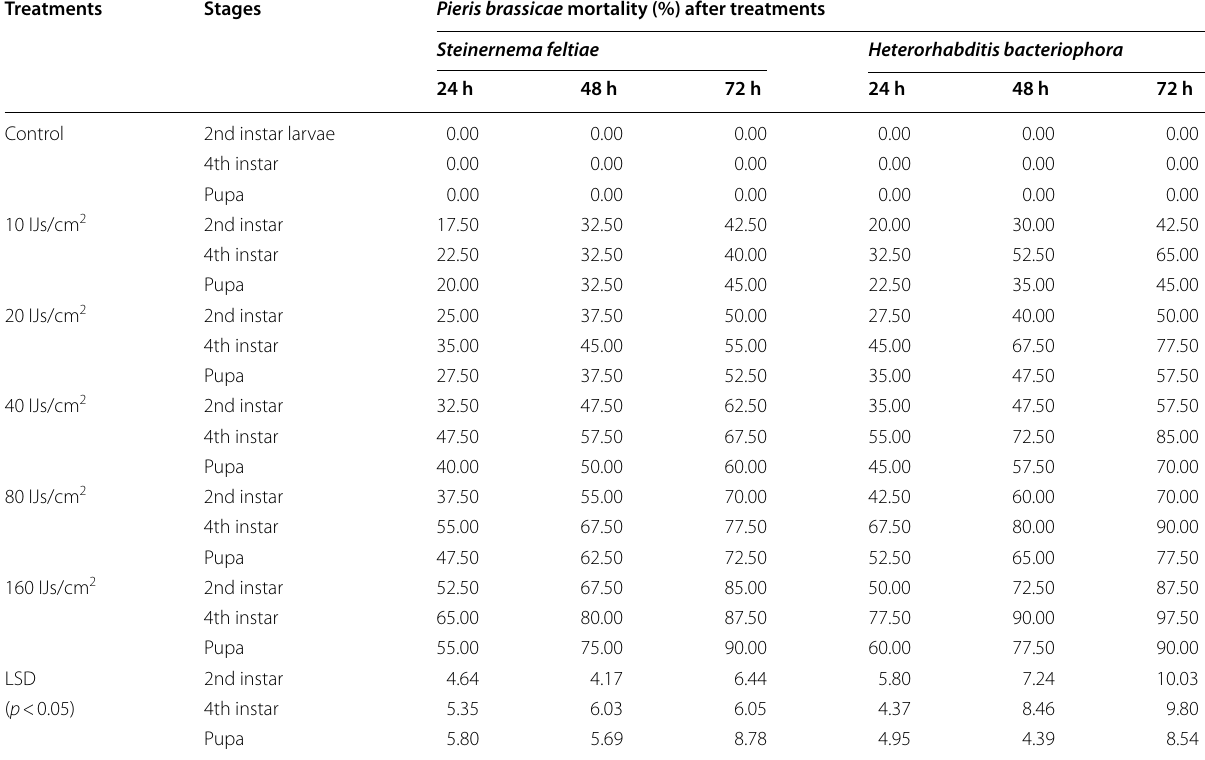
Table 1 Mortality % of cabbage butterfly, Pieris brassicae stages after entomopathogenic nematode treatments Treatments Stages Pieris brassicae mortality (%) after